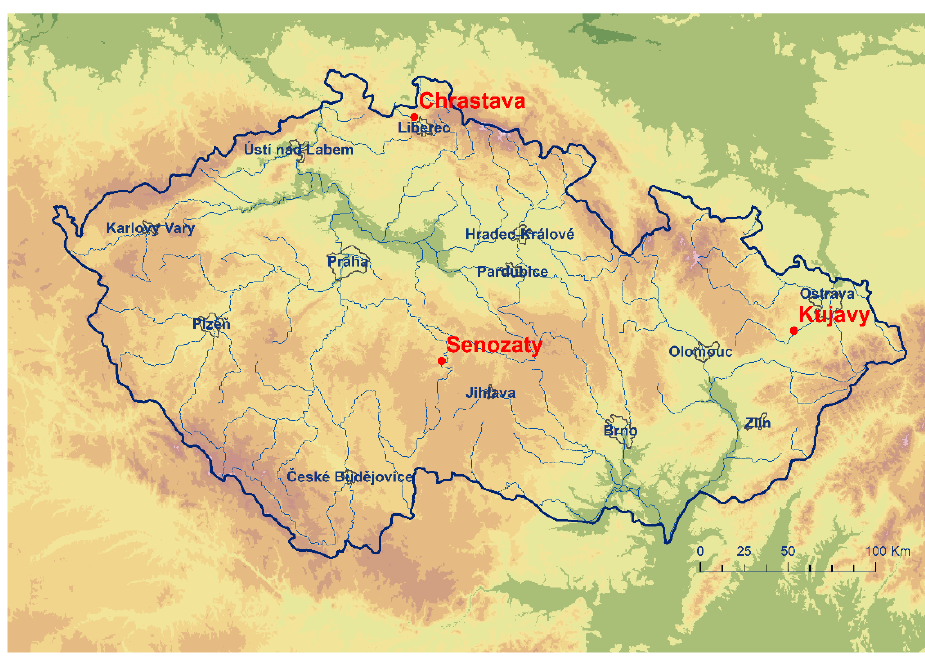
Figure 2. Map of selected CHMI stations. Table 1. Characteristics of phenological (P) and climatological (C) stations including Quitt‘s classification [17]. Station